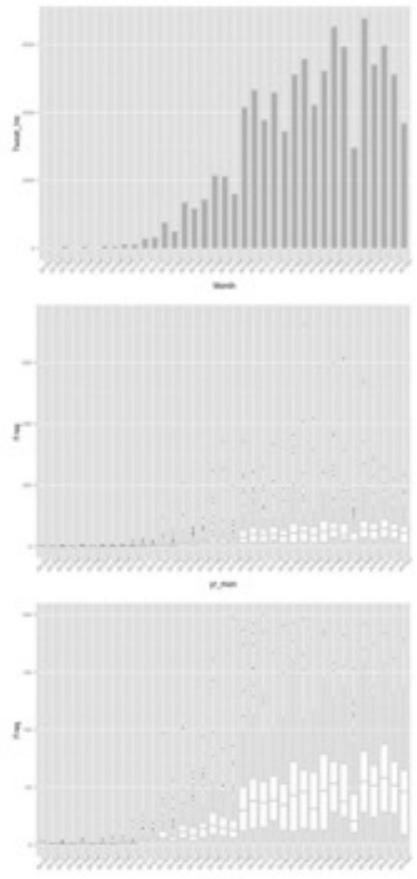
Figure 2. The Monthly Distribution of Postings between 2012 and